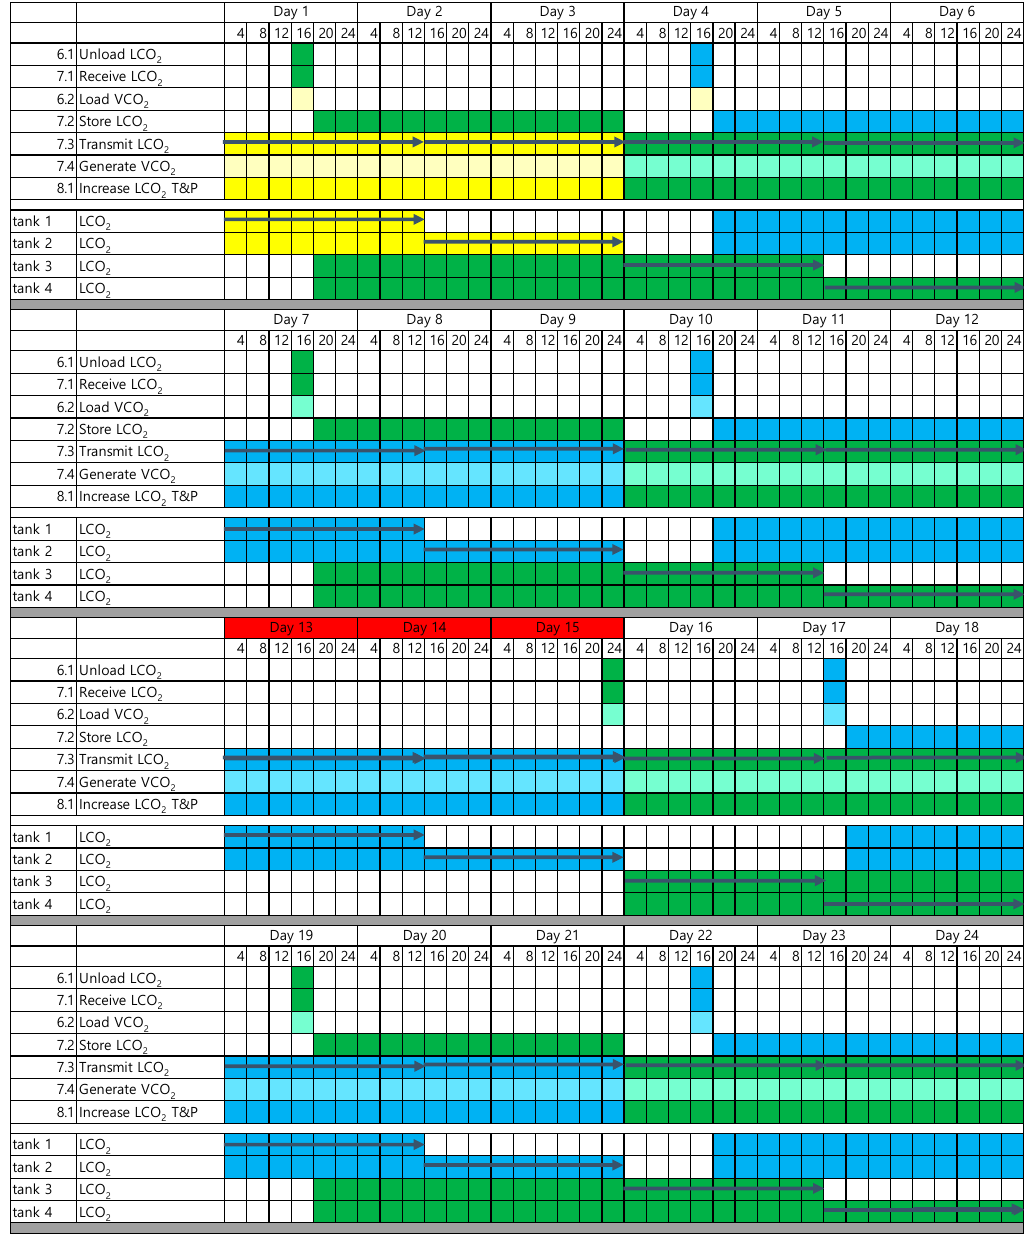
Figure 7. Timelines for the activated functions and CO 2 storage tanks status. The green and blue colors show each carrier shipping CO 2 . The yellow represents the initially filled CO 2 and the red corresponds to an emergency period.